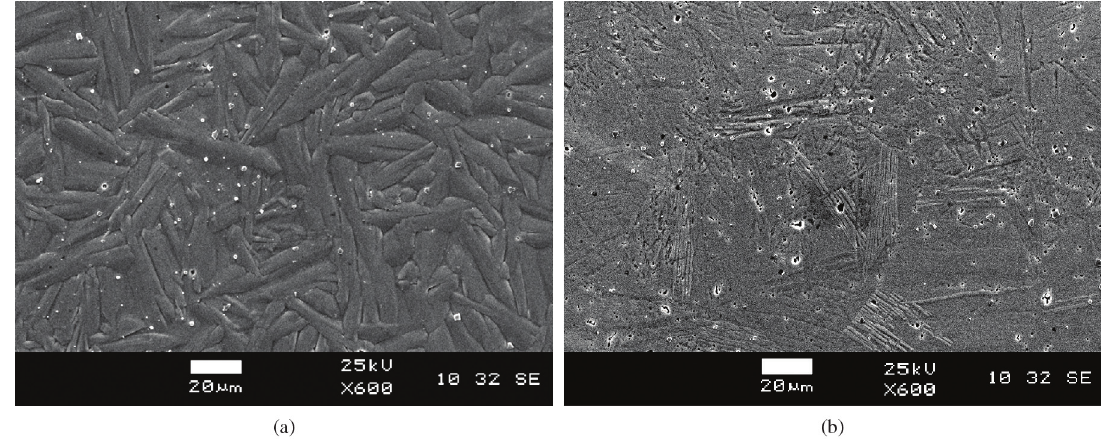
Figure 2. SEM backscattered electron images (ND-TD) of Ti55Ni alloy: (a) solution treated and (b) deformed by 1 ECAE pass.